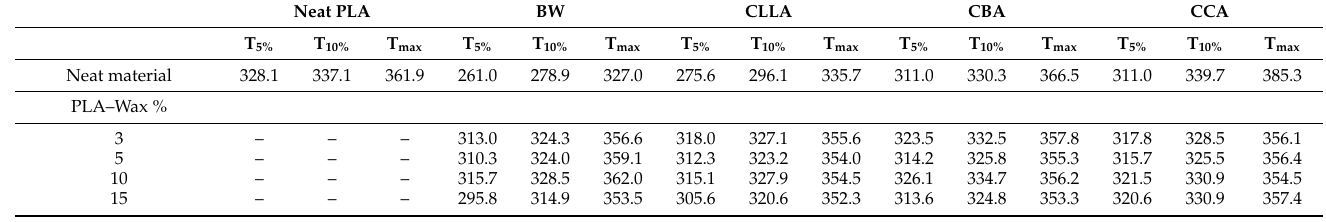
Table 1. Data were obtained from the TGA thermograms of the PLA–beeswax (PLA–BW), PLA–